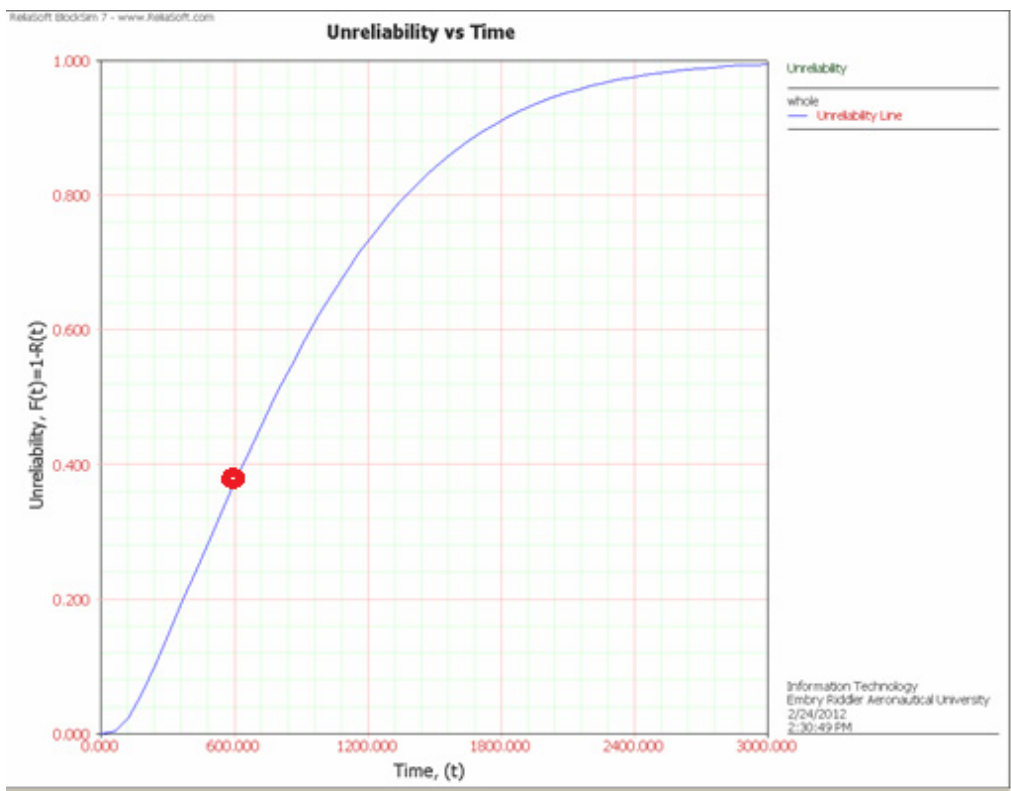
Figure 9. Unreliability as a function of